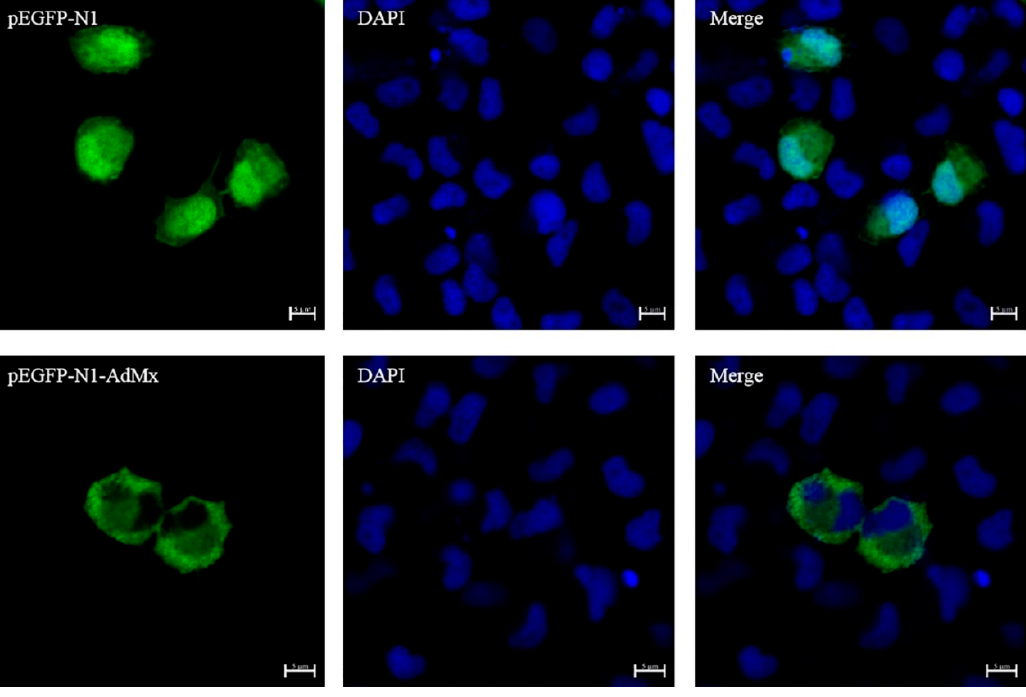
Figure 6. Cytoplasm location of AdMx in transfected GSM cells. GSM cells were transfected with pEGFP-N1-AdMx and stained with DAPI at 48 h post transfection. Scale bar, 5 μ m.